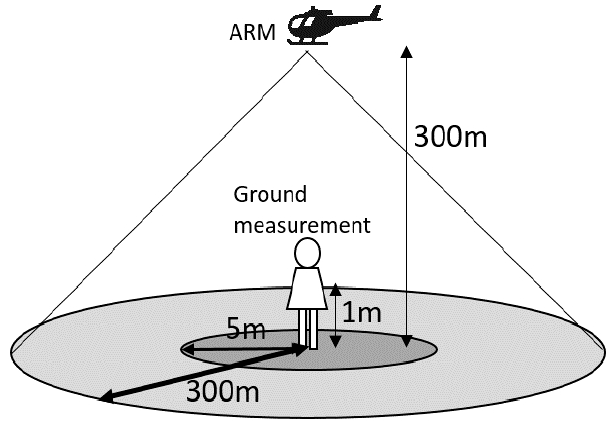
Figure 2. Conceptual schema of the geometrical difference between ARM and ground measurement.